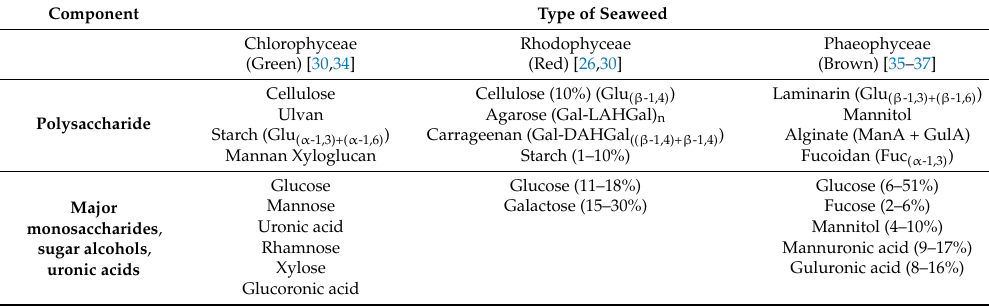
Table 2. Composition of sugars in